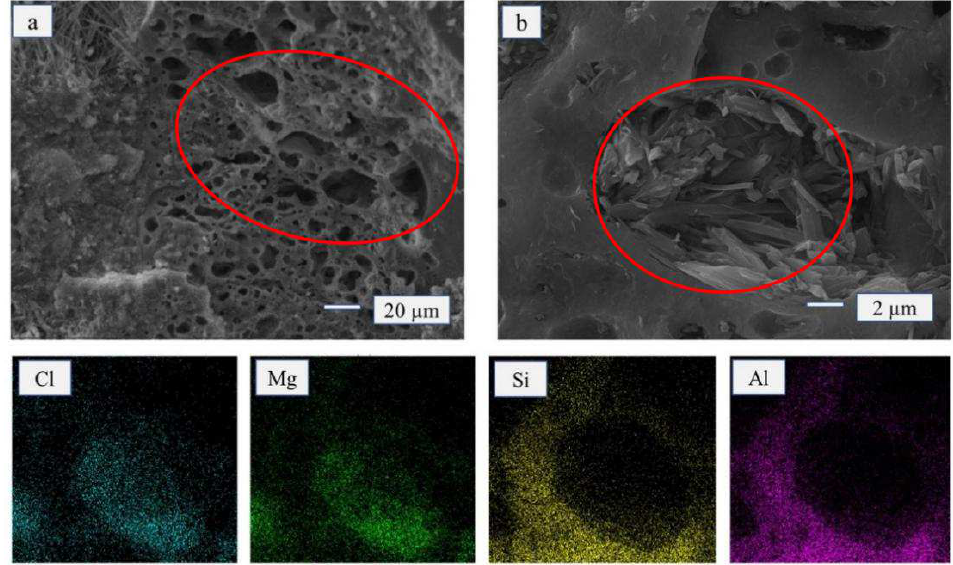
Figure 3. SEM and EDS of FA and MOA-FA. ( a ) FA; ( b ) MOPB-FA (15 wt%); (Cl, Mg, Si, and Al) EDS for the figure ( b ) area.